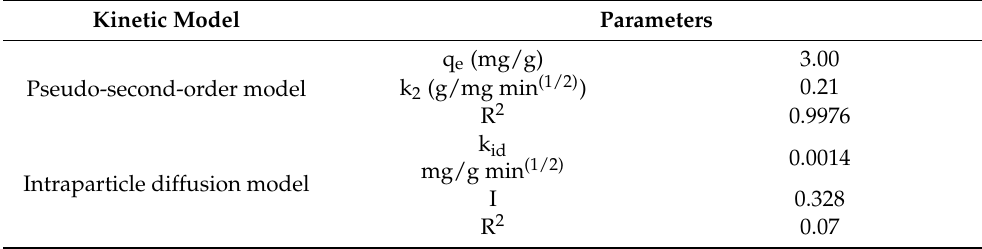
Figure 8. Intra ‐ particle diffusion kinetic model.